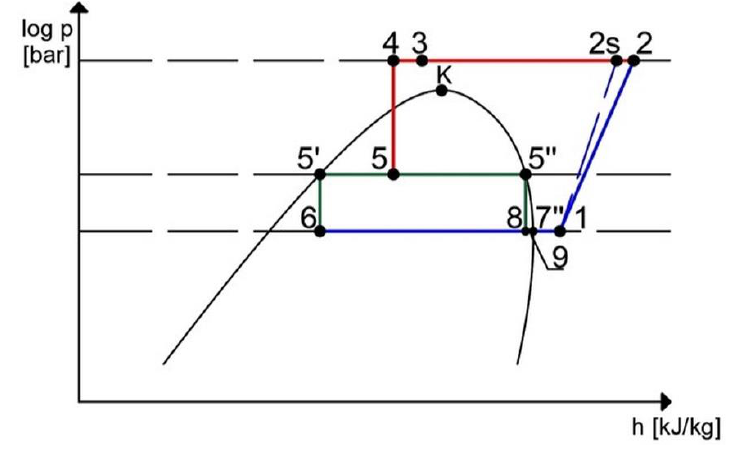
Figure 5. Supercritical carbon dioxide cycle at the beginning of the analysis.